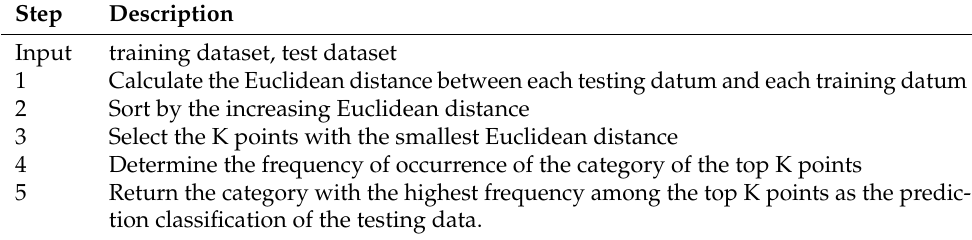
Table 5. Flowchart of the KNN